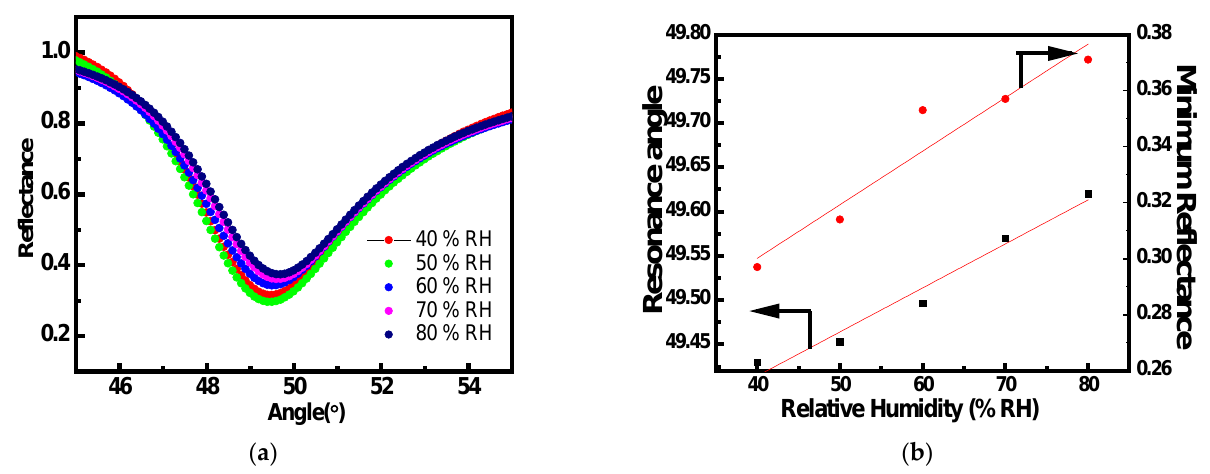
Figure 7. ( a ) SPR reflectance curves for prism/Au/SnO 2 /PPy structure on exposure to 10 ppm concentration of NH 3 gas under varying humidity conditions, and ( b ) Resonance angle ( θspr )(as shown by red dot) and Minimum Reflected Intensity (Rmin)(as shown by black box) variation with relative humidity.